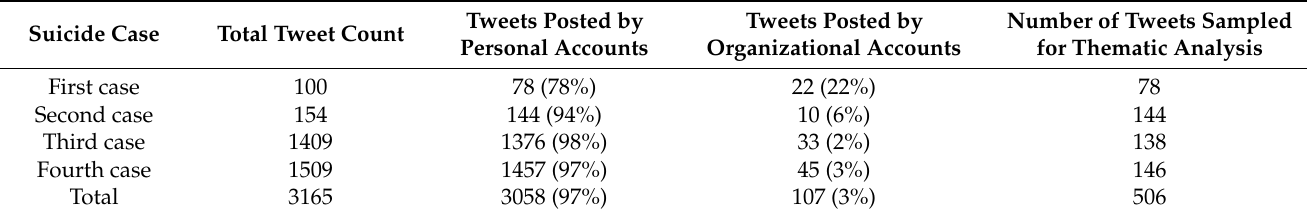
Table 1. Characteristics of tweets and the number of tweets sampled for thematic